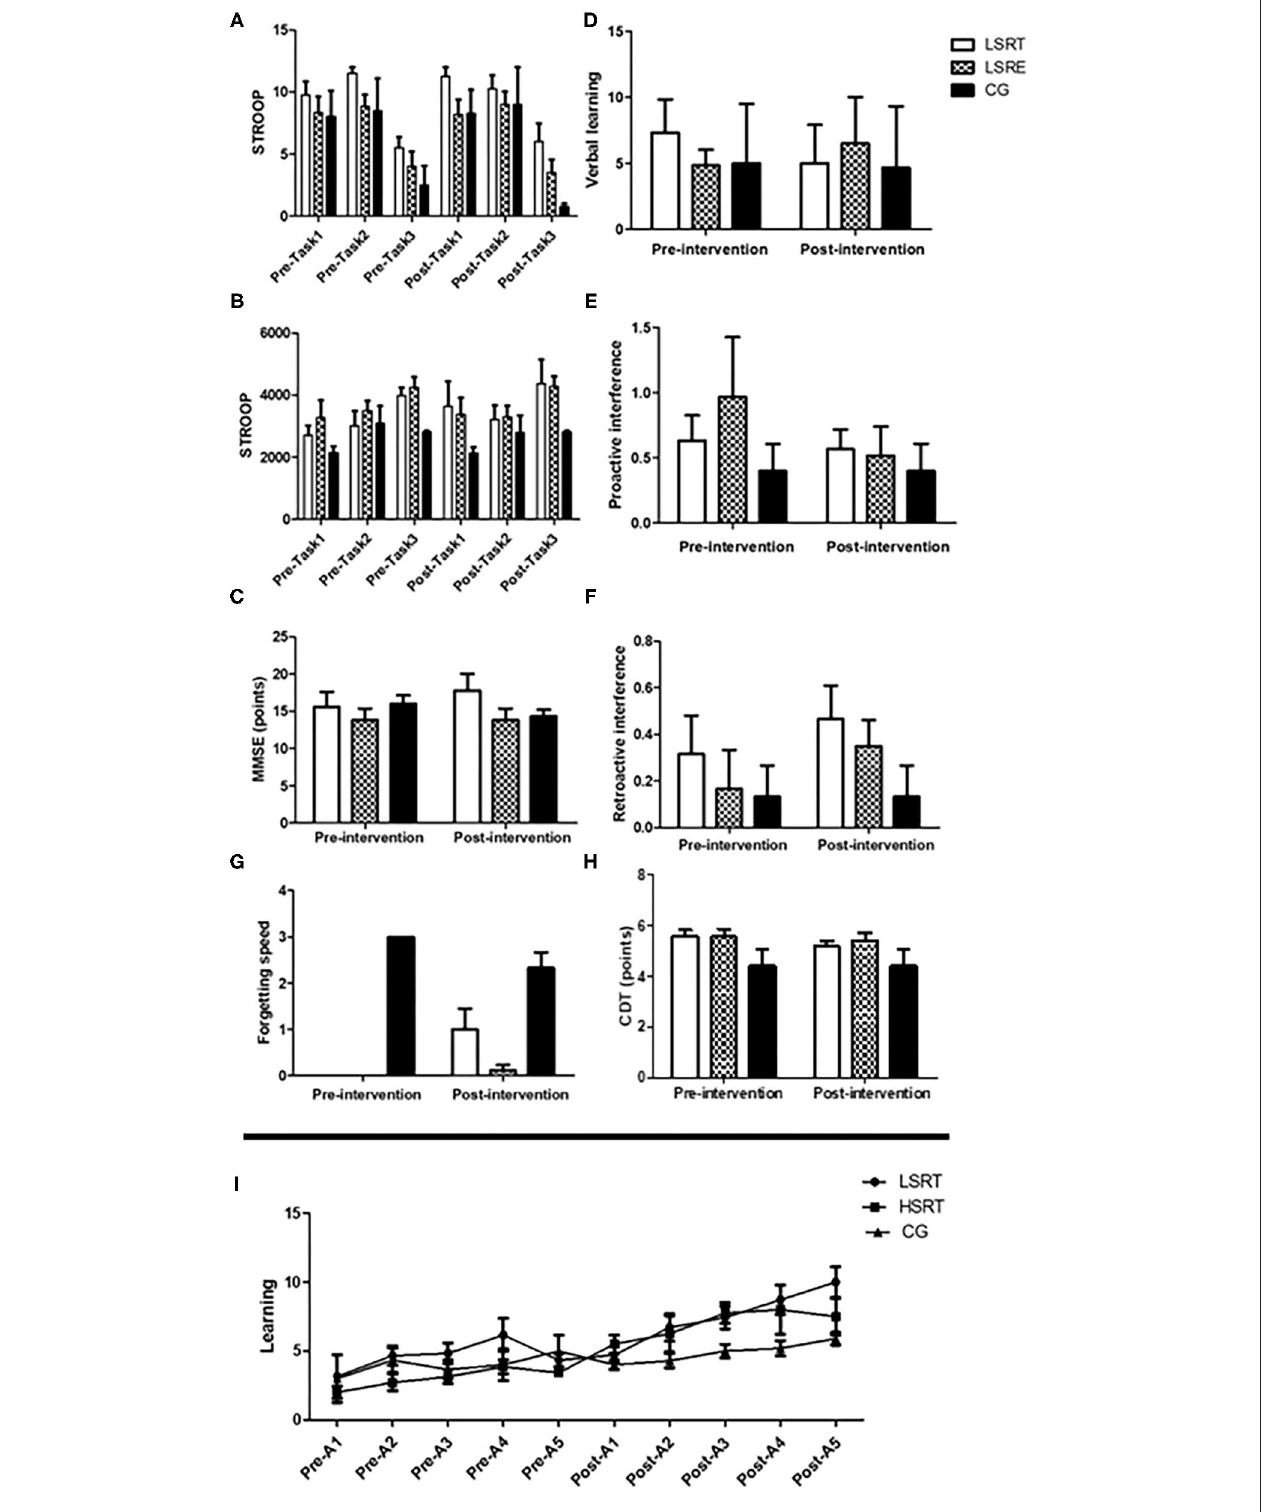
FIGURE 4 | Effects of RT on cognitive parameters in prefrail older adults. Stroop test (A,B) , Mini-mental state examination (MMSE; C ), The Rey’s auditory verbal learning test (D–G,I) and Clock Drawing Tests (H) . LSRT, Low-speed resistance training; HSRT, High-speed resistance training; CG, Control group; MMSE.